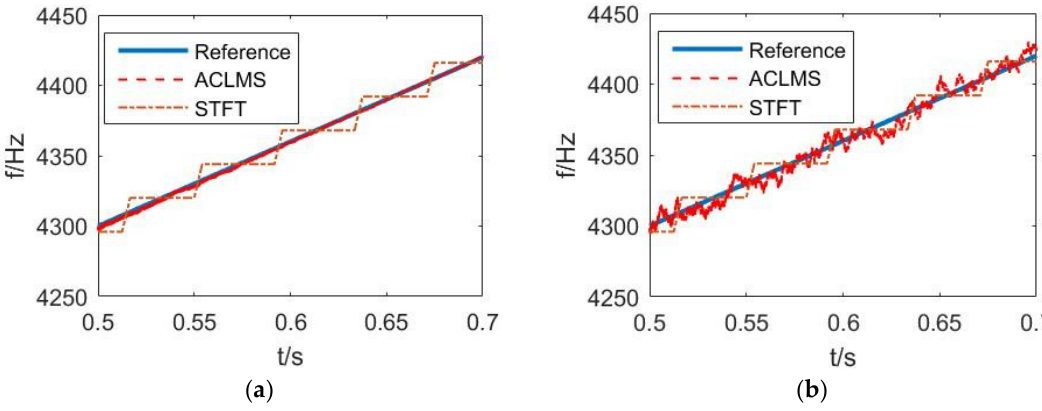
Figure 3. Frequency estimation based on ACLMS and STFT: ( a ) SNR = 57 dB; ( b ) SNR = 37 dB.